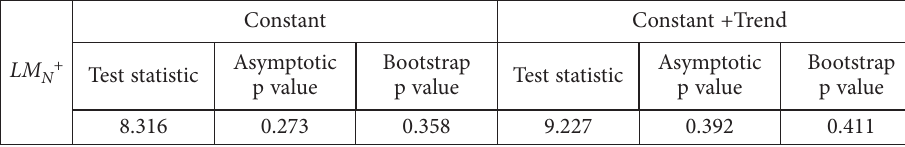
Table 6. Westerlund and Edgerton (2007) LM bootstrap panel cointegration test (H 0 : There is the coin- tegration relationship among the variables) Constant Constant +Trend LM N+